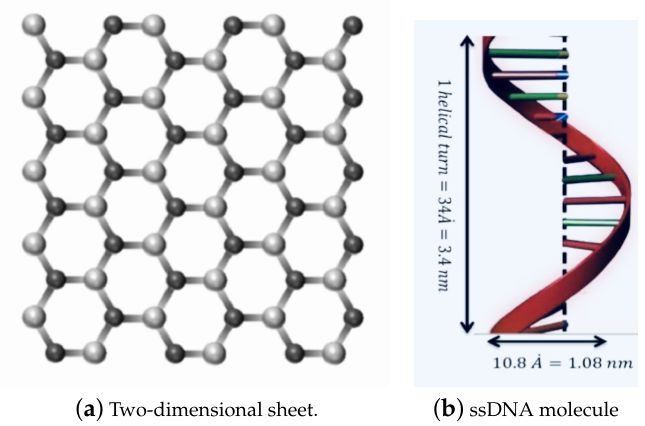
Figure 1. Geometry of: ( a ) a two-dimensional sheet; and ( b ) one turn of the helix of the ssDNA